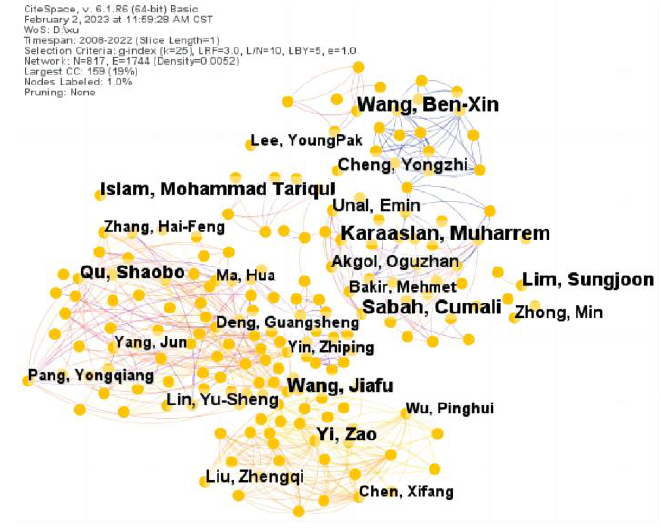
Figure 4. Author collaboration network map. Table 3. Top ten most productive authors in the research of metamaterial absorber. No.